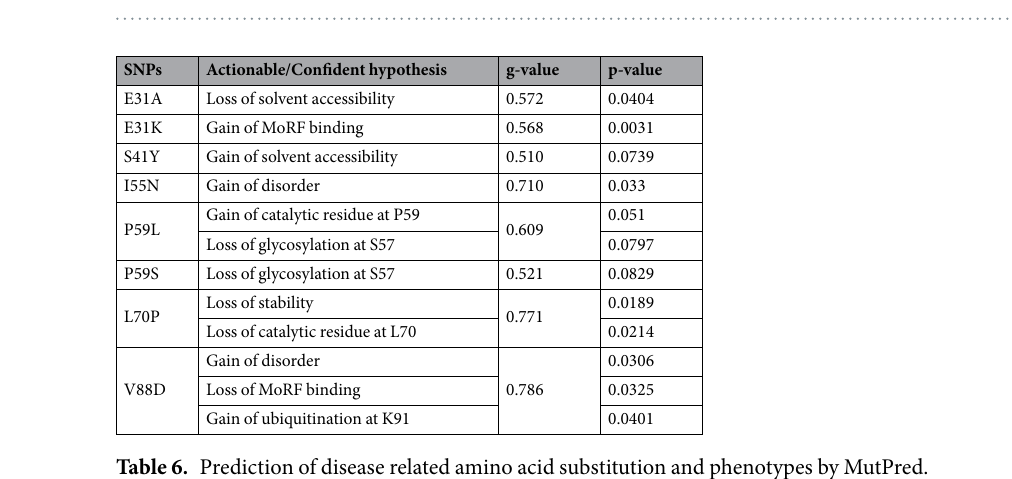
Table 5. Prediction of disease related amino acid substitution and phenotypes by nsSNPAnalyzer.